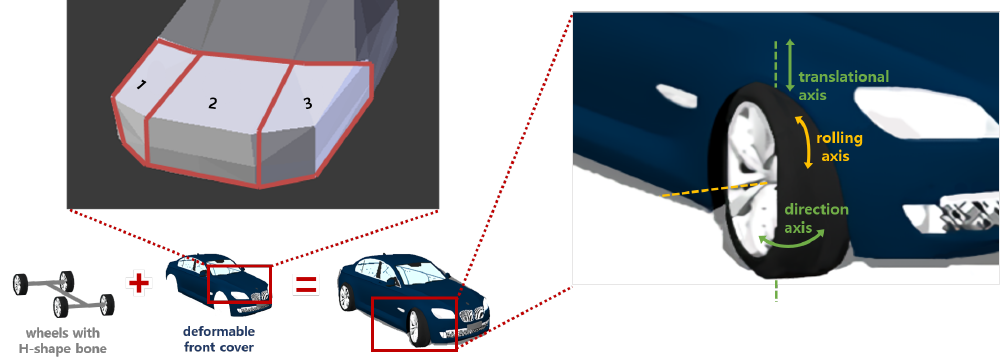
Figure 1. Vehicle model: deformable front cover with rotational and translational axes used for wheel